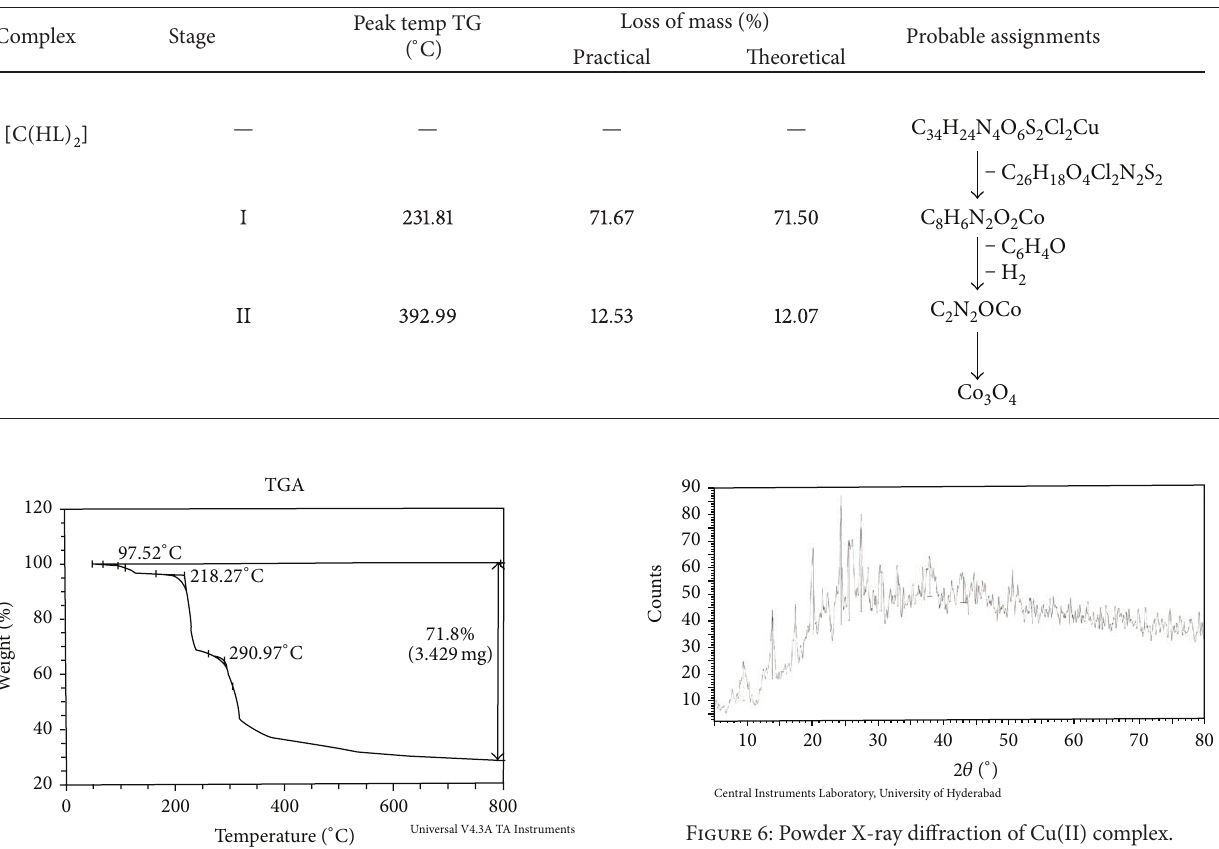
Figure 4: Thermogram of Cu(II) complex.